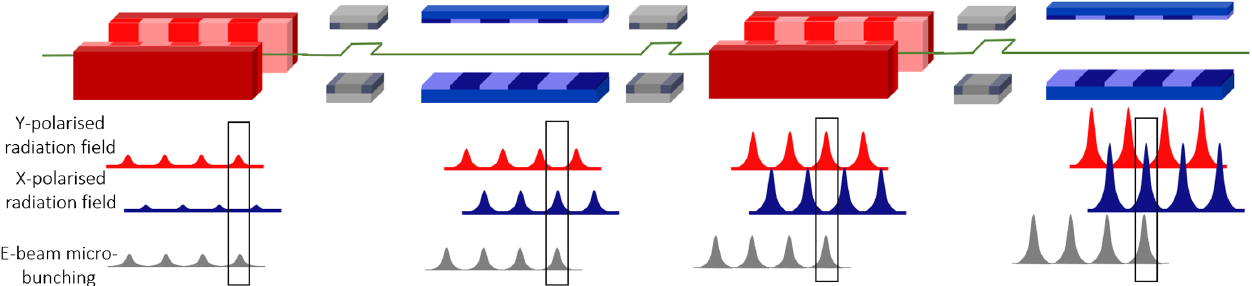
FIG. 1. Schematic layout of a section of afterburner used to generate a radiation pulse train with alternating x and y linear polarization. In each undulator, those regions of the electron beam with modulated microbunching emit coherently. Chicanes delay the electron beam between undulator modules so that those sections of high microbunching overlap with the appropriately polarized pulse for the undulator in which they are